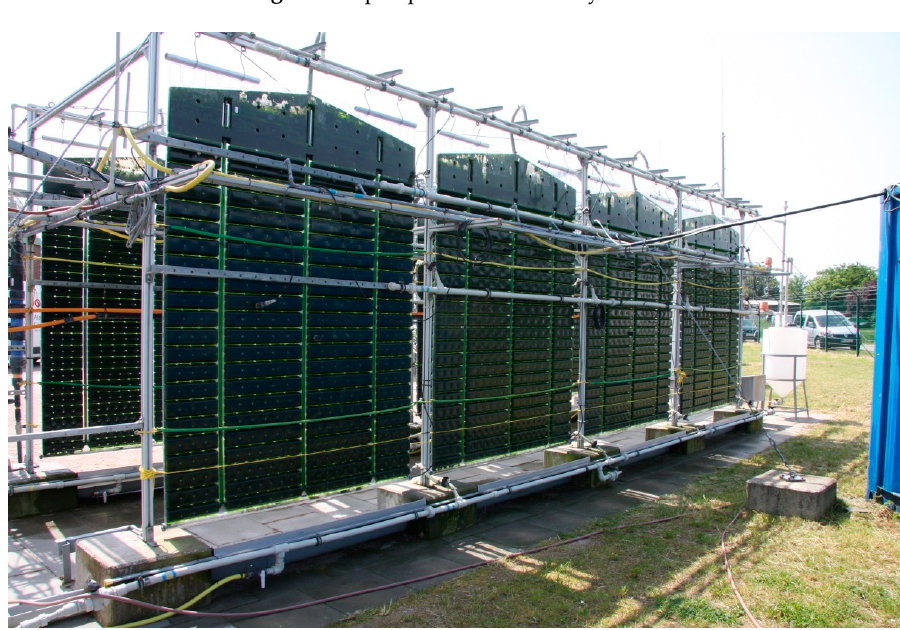
Figure 6. Flat panel photobioreactors (PBRs) cultivation system.